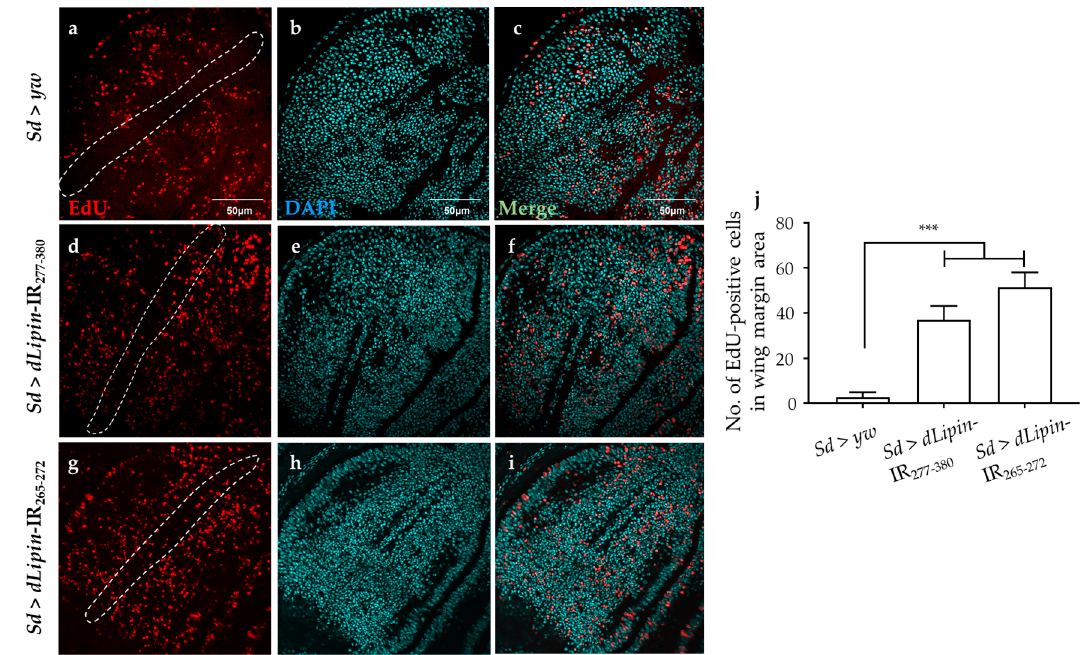
Figure 3. Knockdown of dLipin induces accumulation of cells in S phase. Wing imaginal discs from 3rd-instar larvae of control ( Sd > yw ) and dLipin- kd flies ( Sd > dLipin -IR 265-272 and Sd > dLipin -IR 277-380 ) were stained with DAPI to visualize the DNA ( b, e, h ) and click-iT 5-Ethynyl-2 ′ -deoxyuridine (EdU) Alexa Fluor TM 594 ( a, d, g ). Merged images of DAPI and EdU staining are shown ( c, f, i ). The number of EdU-positive cells in S phase in the wing margin area of 3rd-instar larvae, circled with a dotted line, were analyzed using MetaMorph software ( n = 10 for each genotype) ( j ). Dotted line indicates the margin of the wing imaginal disc. Data are expressed as the means ± S.D. The statistical significance of the difference between control and dLipin -kd flies was evaluated using one-way ANOVA. Scale bar, 50 µm. ***, p < 0.01. IR, inverted repeat. Genotypes: Sd -GAL4/+; +; + ( a – c ), Sd -GAL4/+; UAS -dLipin- IR 277-380 /+; + ( d – f ), Sd -GAL4/+; UAS -dLipin- IR 265-272 /+; + ( g – i ).